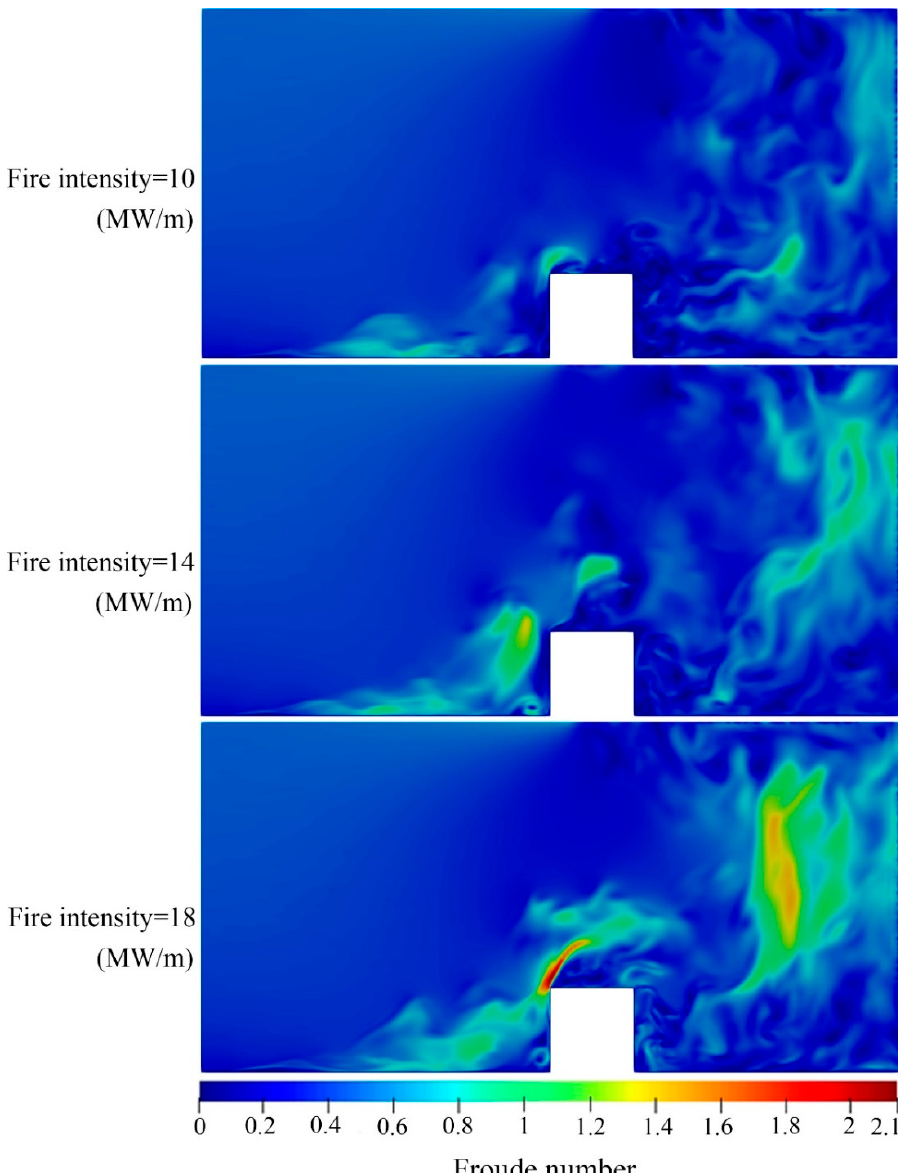
Figure 6. Contours of Froude number distribution for fire intensities of 10, 14, and 18 MW/m.